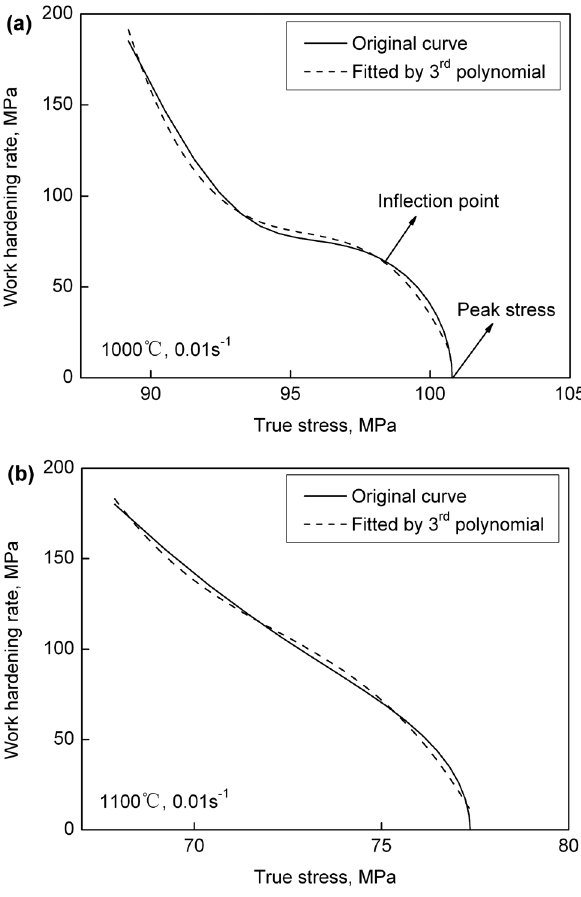
Fig. 9: Plots of critical stress and strain versus (a) peak stress and (b) peak